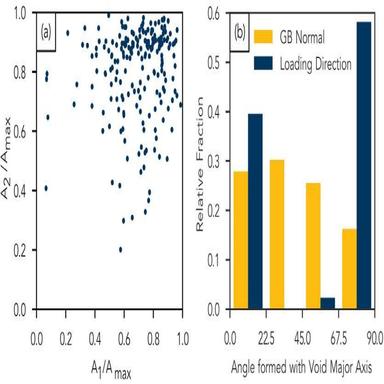
(a) Aspect ratios of the 1-4NVs, where A1 and A2, the minor axis lengths, were unsorted. (b) The distribution in the angle formed between the void major axis and 1) the grain boundary normal vector and 2) the loading direction for 2NVs.